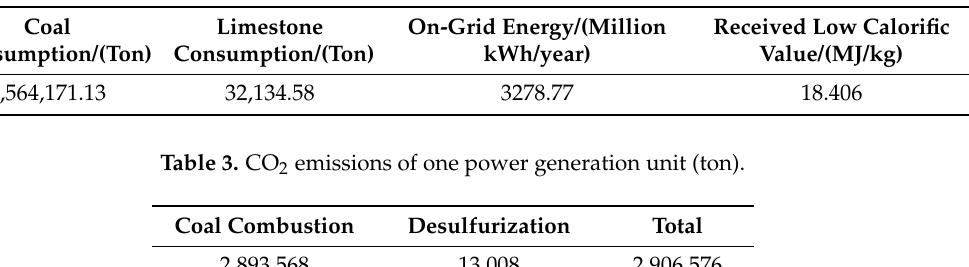
Table 2. Parameters of CO 2 emissions.